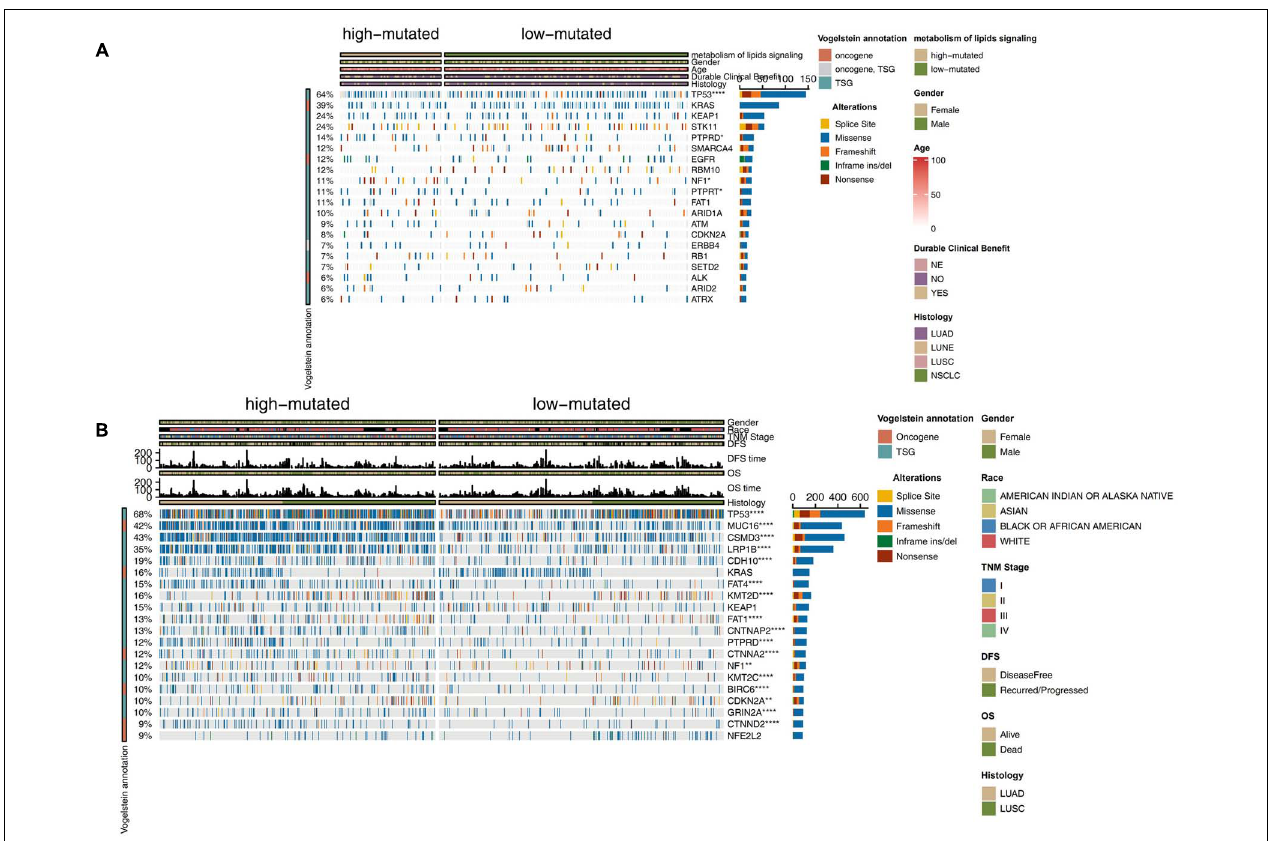
FIGURE 2 | Genomic profiles of NSCLC patients in the ICI-treated cohort (Rizvi et al., 2018) (A) and TCGA-NSCLC (B) cohorts. The top 20 genes with the highest mutation frequencies and the corresponding clinical information are shown. The top five genes with the highest mutation frequencies in the ICI-treated cohort (Rizvi et al., 2018) were TP53, KRAS, KEAP1, STK11, and PTPRD. The top five genes with the highest mutation frequencies in the TCGA cohort were TP53, TTN, MUC16, CSMD3, and RYR2. The mutation types are indicated as follows: yellow indicates splice site mutations, blue indicates missense mutations, orange indicates frameshift mutations, green indicates in-frame insertions/deletions, and brown indicates nonsense mutations. The clinical characteristics are shown as patient